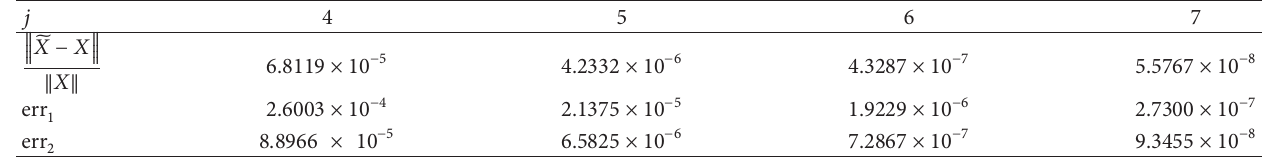
Table 2: Perturbation bounds for Example 1 with different values of j .